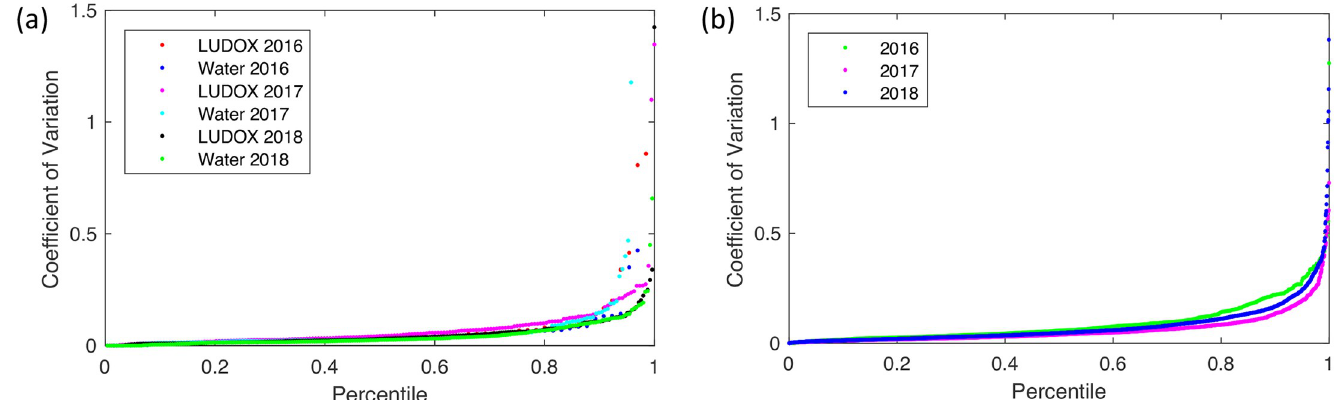
Fig 2. Distribution of the coefficient of variation. Distribution for valid replicate sets in LUDOX and water calibrants for OD (a) and fluorescein calibrant for fluorescence (b). All distributions show an overall high degree of precision and similarity, except for the small fraction of outliers in the LUDOX and water calibrants.